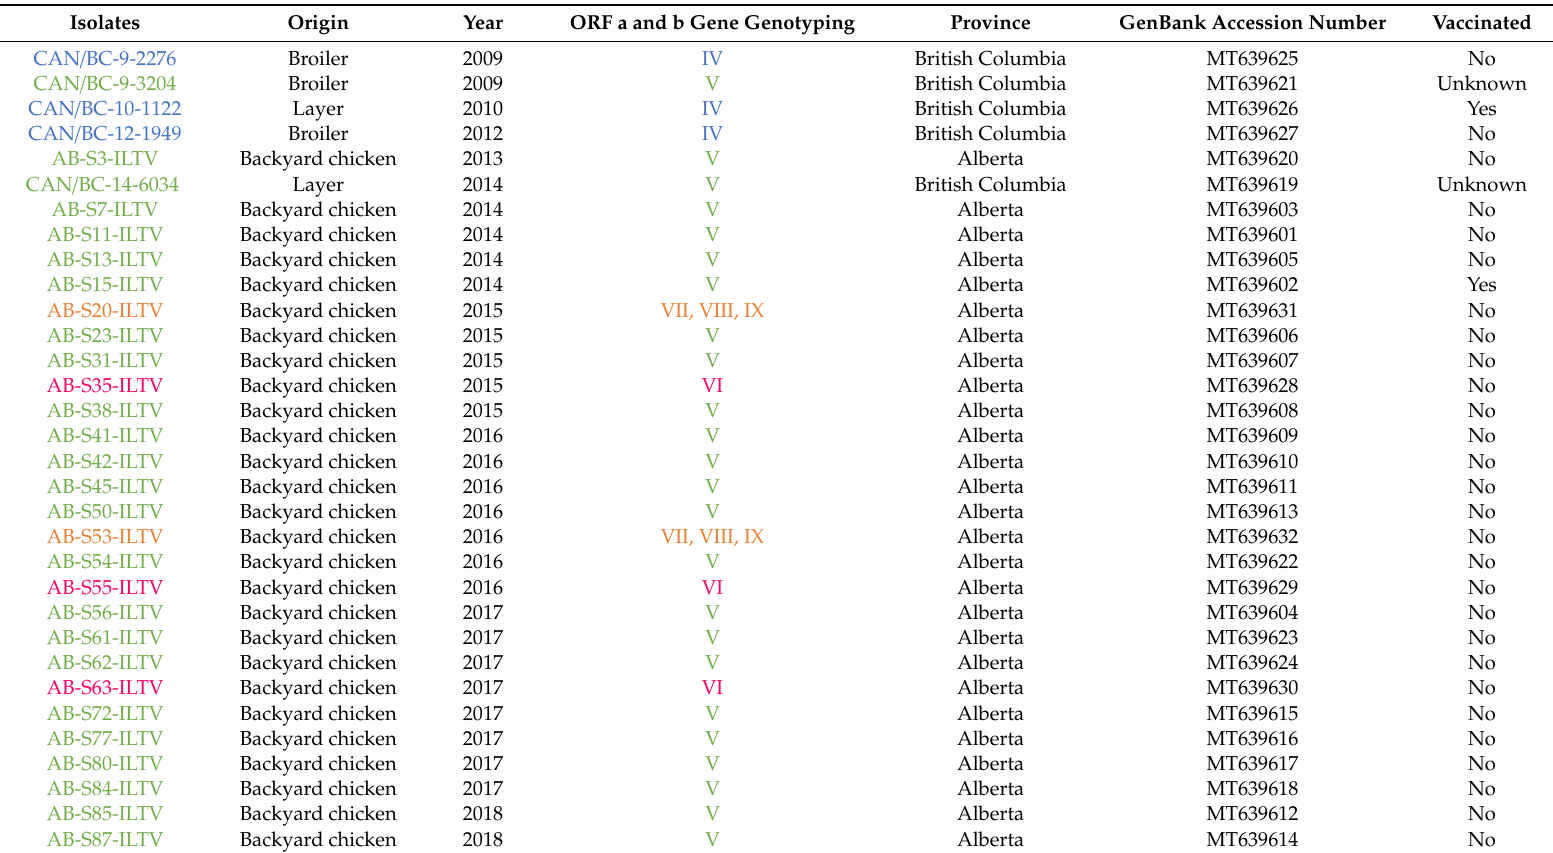
Table 1. Classification of ILTV isolates from AB and BC is arranged by the year. The table includes the type of flock, province of origin, and the vaccination history. Samples name and genotype have been color-coded as the phylogenetic